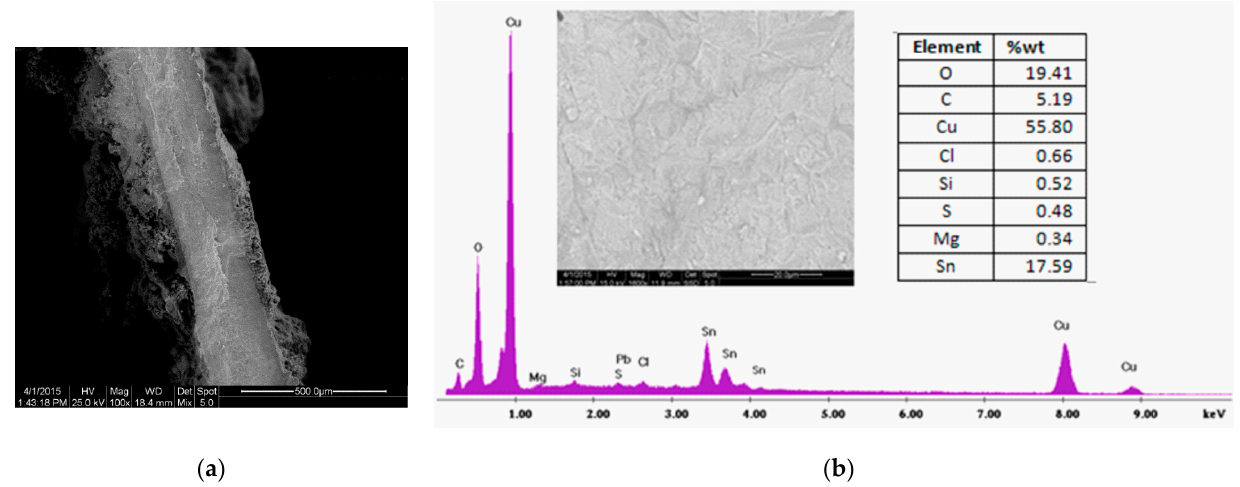
Figure 8. SEM image of the cross-section of the fragment No. 10816: ( a ) Magnification 100×; ( b ) Magnification 1600× and EDX analysis.